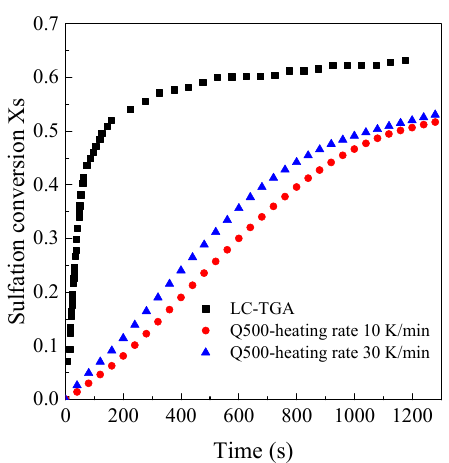
Figure 6. The comparison of sulfation conversion in the LC-TGA and the TGA-Q500 (Shengzhou limestone, 3.5 μ m, 850 °C, 2000 ppm).